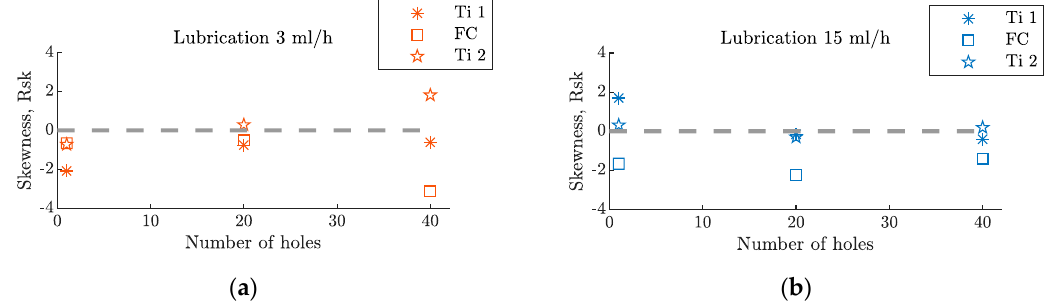
Figure 10. Skewness evolution, after 40 holes, in a hybrid Ti/CFRP/Ti stack with a ( a ) lubrication level of 3 mL/h and a ( b ) lubrication level of 15 mL/h.